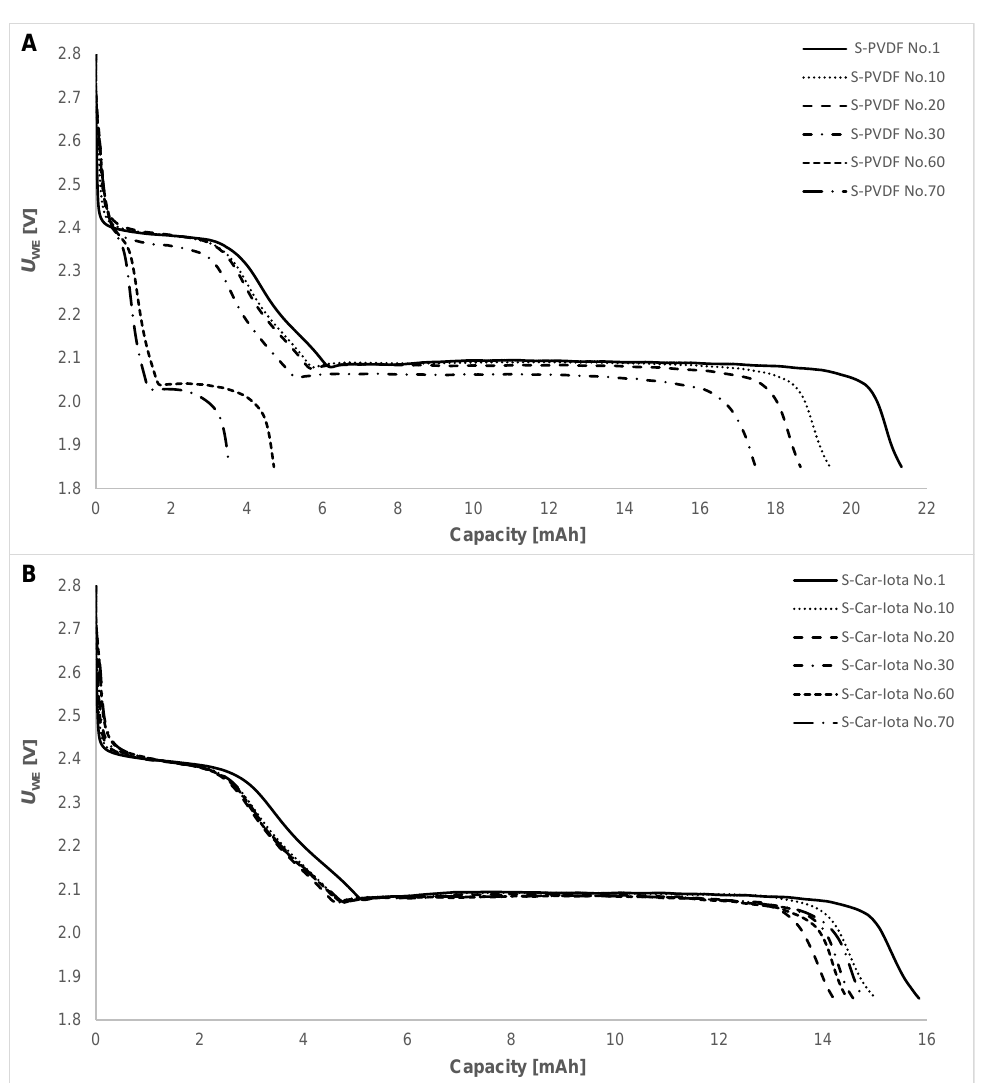
Figure 6. Discharge curves of the ( A ) S-PVDF and ( B ) S-Car-Iota pouch cells during different cycles.